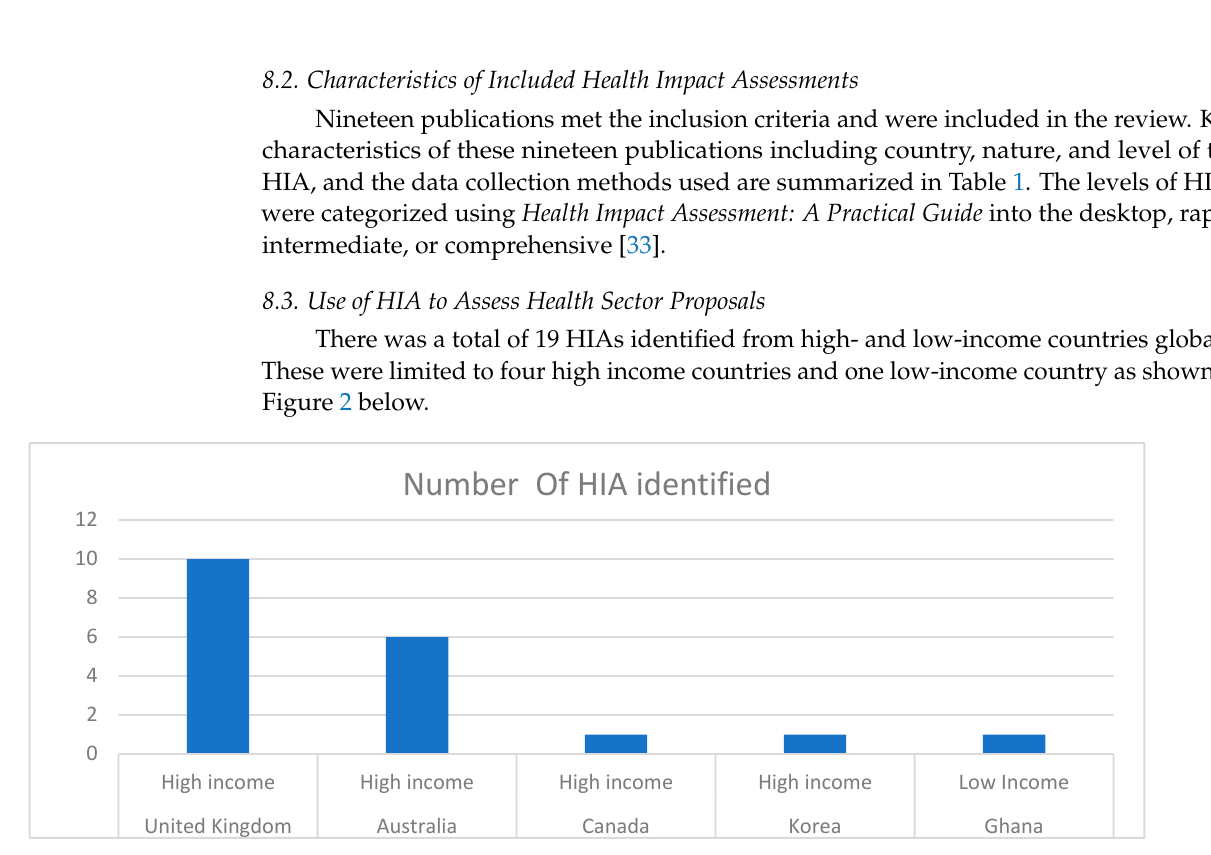
Figure 2. Distribution of HIAs.